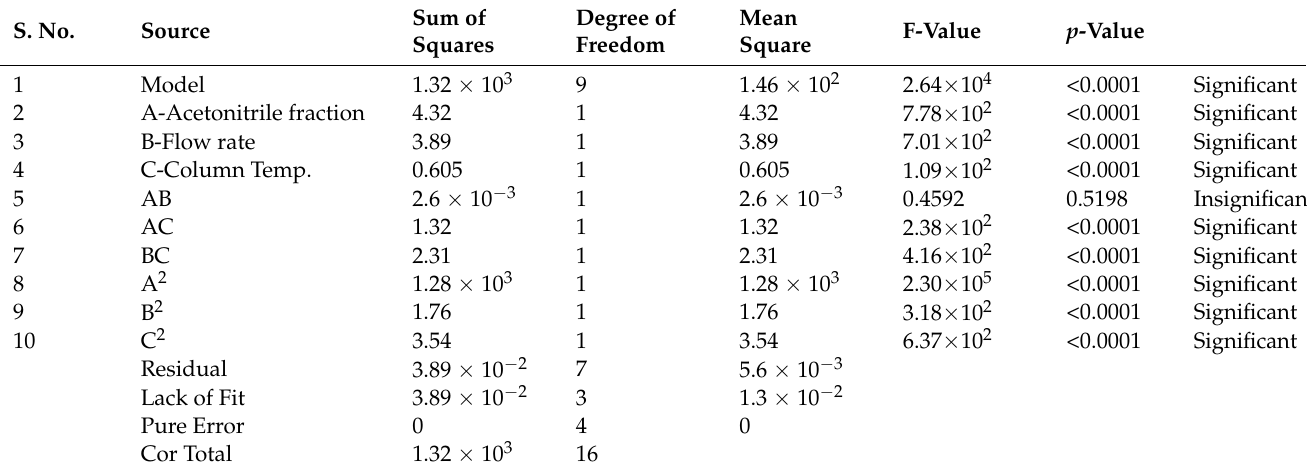
Table 4. Analysis of variance for the quadratic model related with the optimization of variables for the development of the HPLC